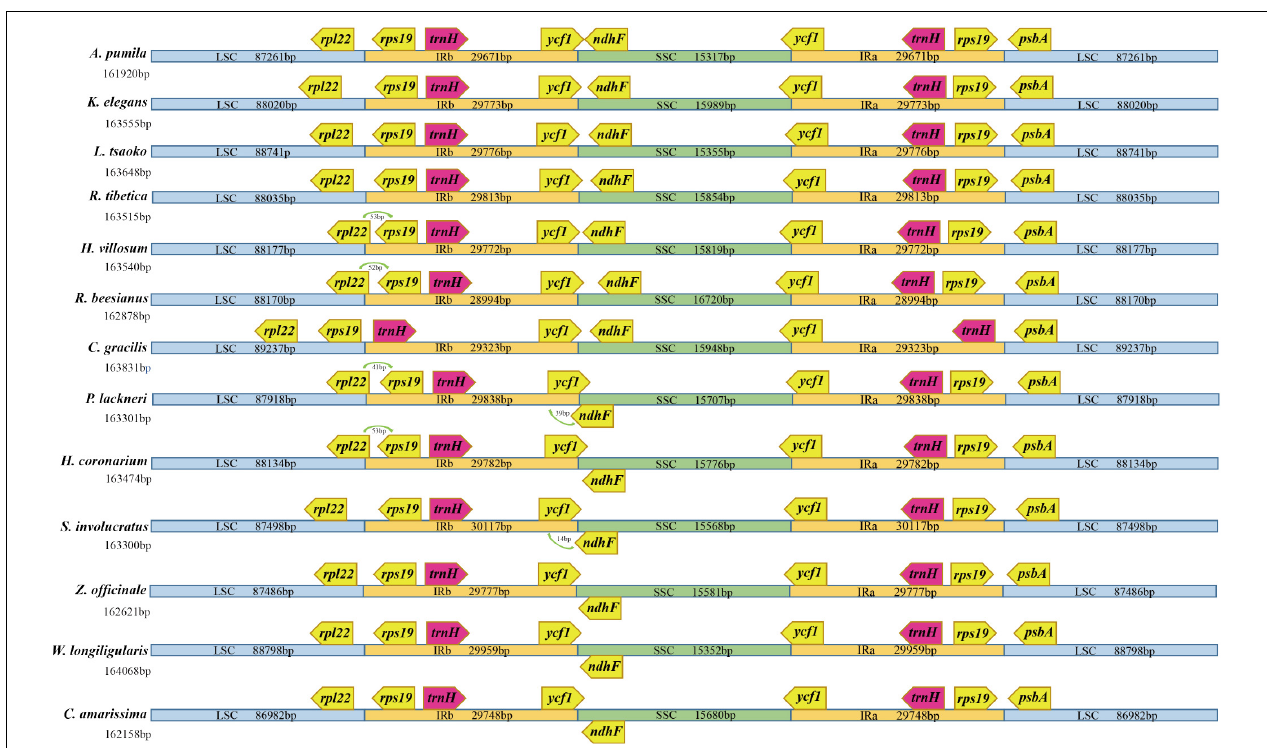
stable, except that the C. gracilis genome lacked an rps19 gene ( Figure 1 ). No gene rearrangements or inversions were observed ( Supplementary Figure 2